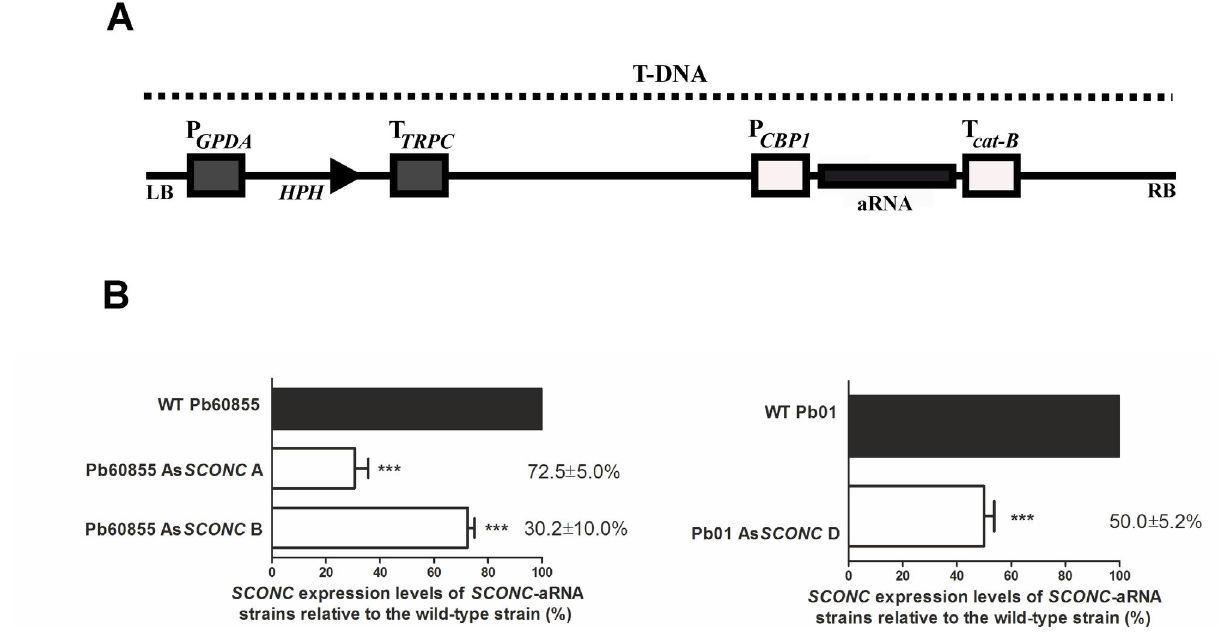
Figure 1. Silencing of SCONC expression by targeted antisense RNA in Paracoccidioides species decreases mRNA levels. ( A ) Structure of aRNA Transfer DNA (T-DNA) cassette inserted into P. brasiliensis yeast cells via ATMT in order to silence SCONC . The antisense RNA (As SCONC ) sequence was placed under control of the calcium binding protein promoter from H. capsulatum (CBP1) with hygromycin B phosphotransferase (HPH) gene under control of the glyceraldehyde 3-phosphate promoter from A. nidulans (PGPDA). ( B ) Gene expression levels of SCONC in Paracoccidioides clones harboring silencing oligonucleotides targeting the SCONC coding sequence compared to the respective wild-type strain. Cells were grown to the exponential phase in complete MMvM (MMvM +Cys/+SO 42- ) at 37°C and collected for gene expression evaluation. Asterisks represent statistical differences between wild-type and down-regulated strains (***p<0.001). Percentage of gene expression levels reduction was obtained comparing SCONC levels of each clone to those of the wild-type strains. SCONC expression levels determined by qRT- PCR were normalized to expression of the internal reference gene β-tubulin (TUB2). Bars represent means and standard